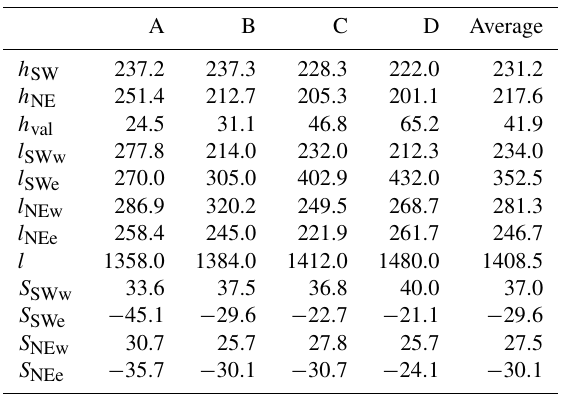
Five points (Table 1) were selected for DTM comparison: towers 20/tse04, 25/tse09 and 29/tse13 – the three 100 m me- teorological towers, comprising a transect aligned with the dominant wind direction – tower 37/rsw06, and the wind tur- bine location along the SW